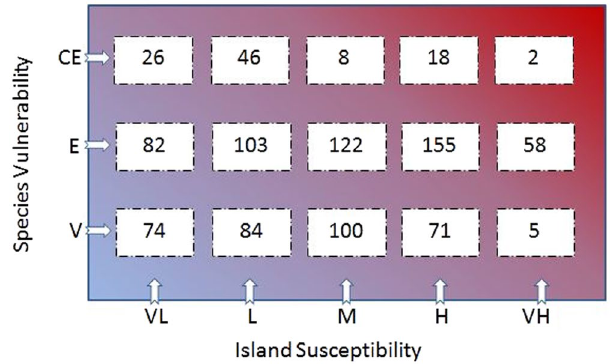
Figure 2. Number of islands that hosted species from different categories.